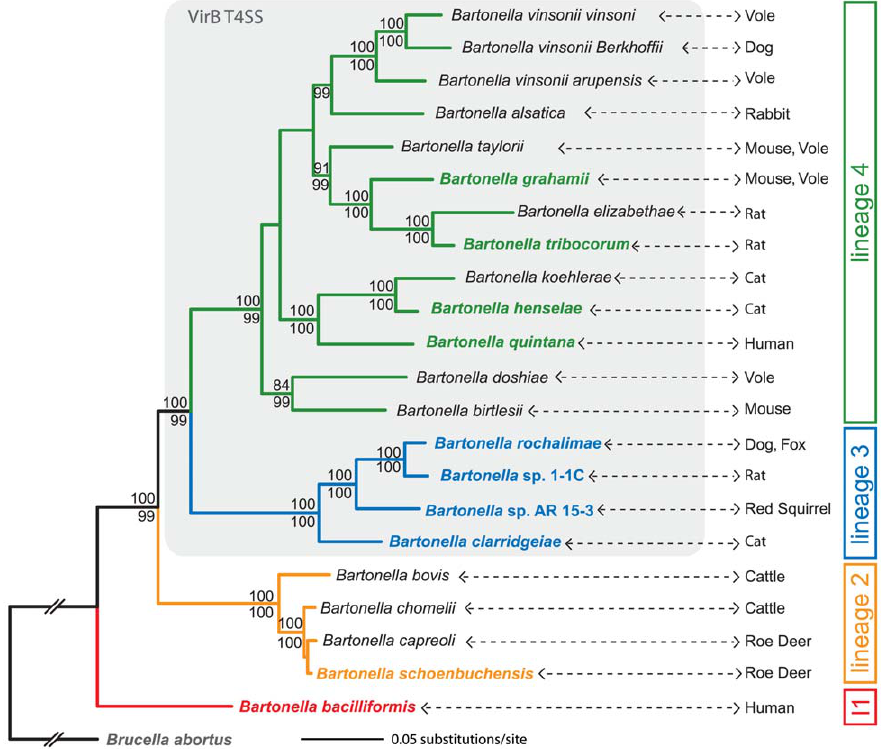
Figure 1. Phylogeny of Bartonella based on a genome-wide dataset. Maximum likelihood analysis using an alignment of 478 genes (515,751 nt) of ten sequenced Bartonella species (indicated by bold and color type) and Brucella abortus . Based on sequence data from rpoB , gltA , ribC , and groEL genes, additional Bartonella species were included in the analysis. Numbers above the branches represent maximum likelihood bootstraps (100 replicates); numbers below represent Bayesian posterior probabilities. Values $ 80% are shown. Lineages harboring the VirB T4SS [16] are shaded in gray; the primary mammalian hosts are indicated for each species. Phylogenetic trees inferred from either the genomic data set excluding non-sequenced bartonellae or the sequences from only rpoB , gltA , ribC , and groEL genes revealed the same four lineages for the Bartonella ingroup (Figure S1). Estimates of average evolutionary divergence over sequence pairs within lineages and between lineages are presented in Table S1. l1, lineage